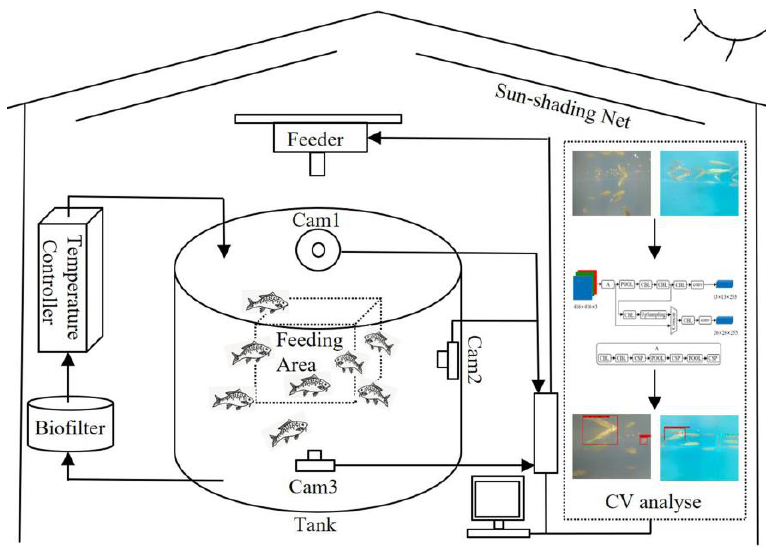
Figure 1. Apparatus for imaging of fry feeding.